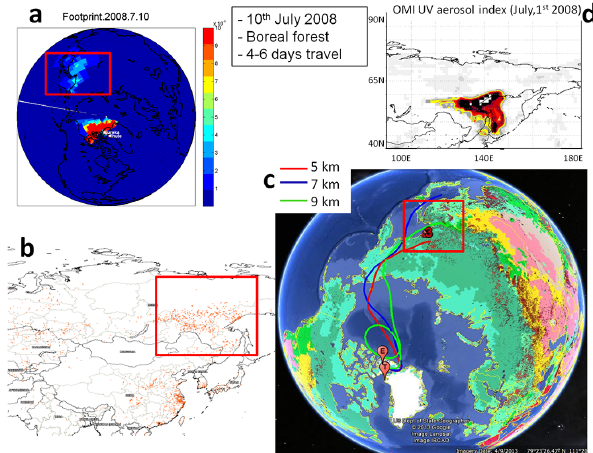
Figure 4. Example of attribution of fire source region and transport time for event number 3, detected at Eureka on 10 July 2008. (a) STILT footprints for that day, (b) MODIS fire hotspots, (c) HYS- PLIT back-trajectories ending that day, and (d) OMI UV aerosol index for that day.